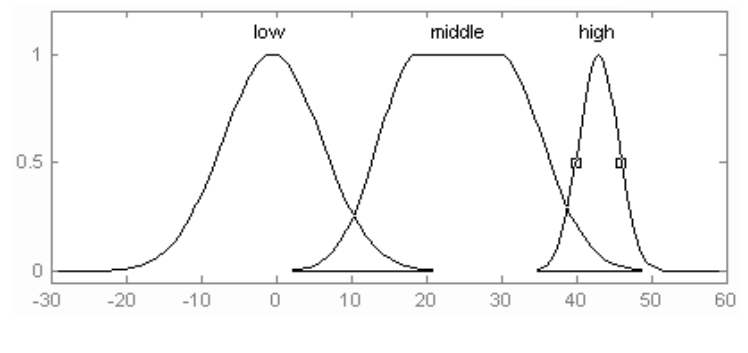
Figure 8. Membership functions of battery temperature.